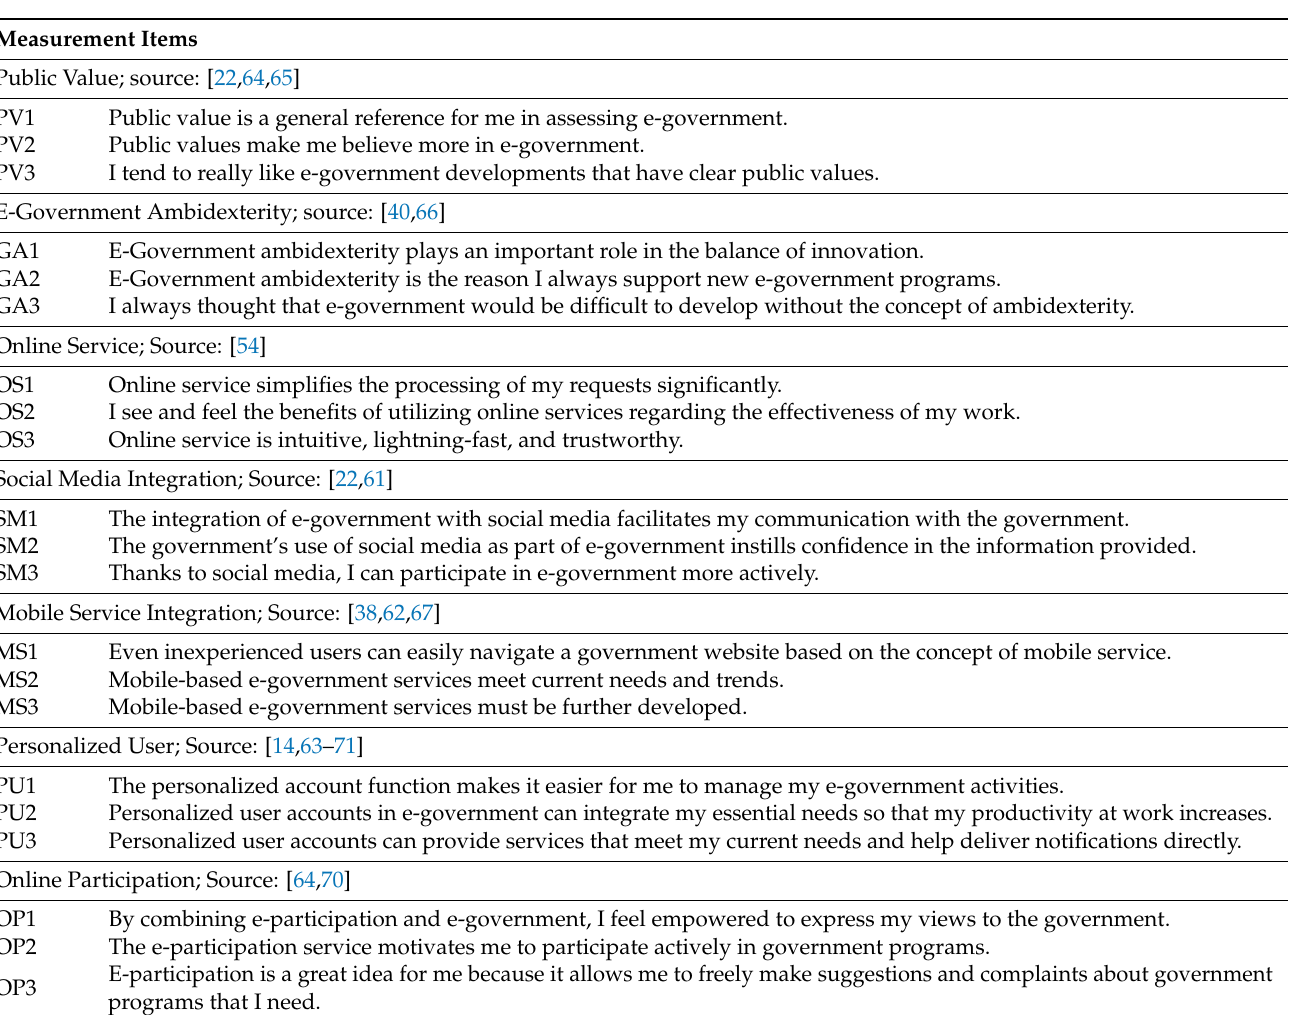
Table 3. Questionnaire measurement